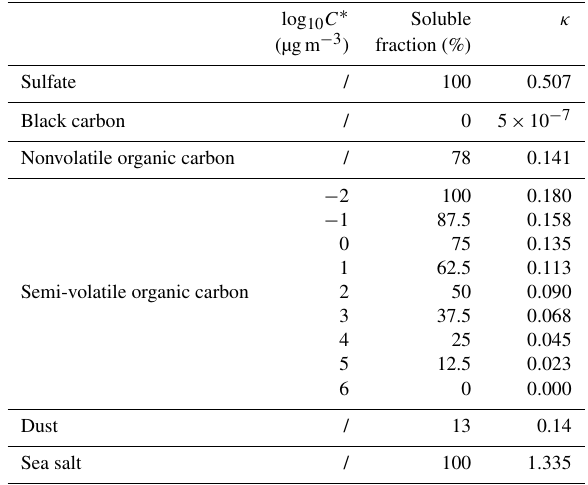
Table 1. Hygroscopicity κ used for each organic aerosol volatility